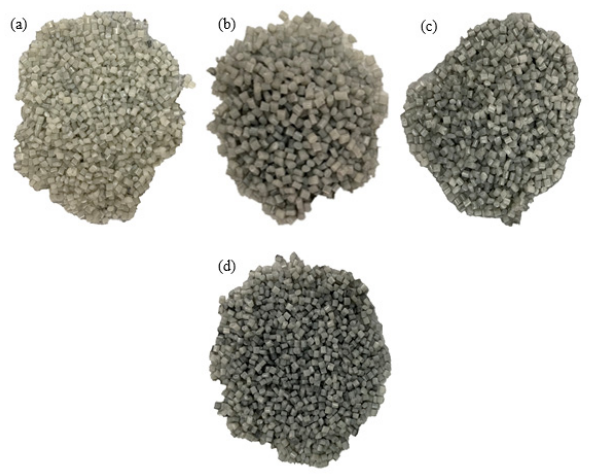
Figure 3. PLA pellets coated with SiC particles, showing PLA-SiC pellets with SiC weight fractions of ( a ) 0.5 wt%, ( b ) 1 wt%, ( c ) 1.5 wt%, and ( d ) 2 wt% SiC.